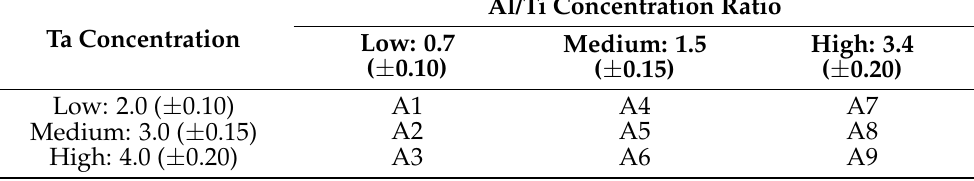
Table 1. IN740 modification procedures,